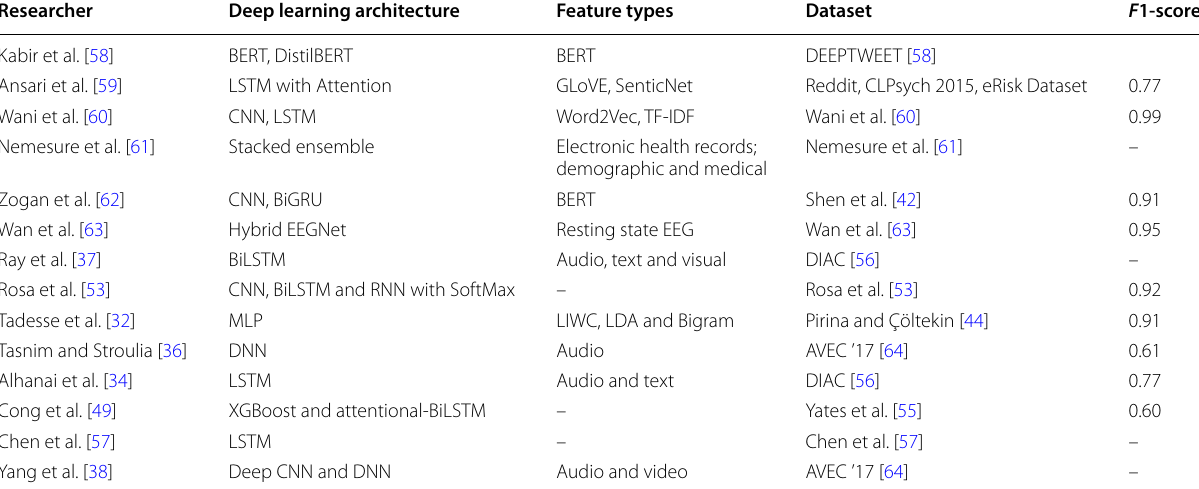
Table 2 Deep learning and neural